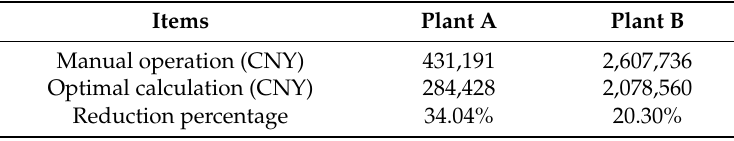
Table 2. The comparison of the electricity purchasing cost for plant A and plant B. Items Plant A